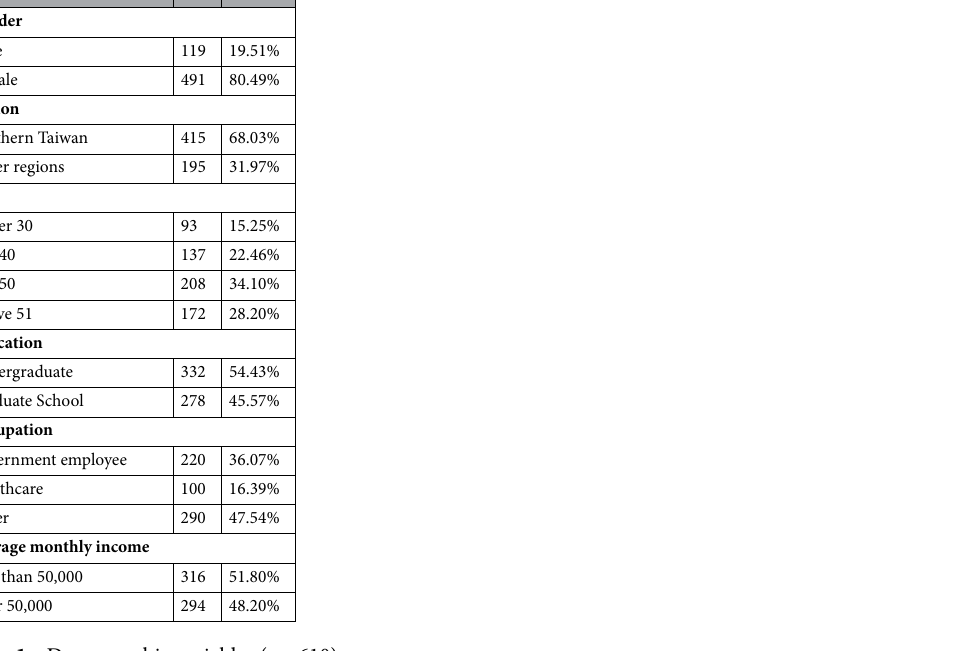
Table 1. Demographic variables ( n =